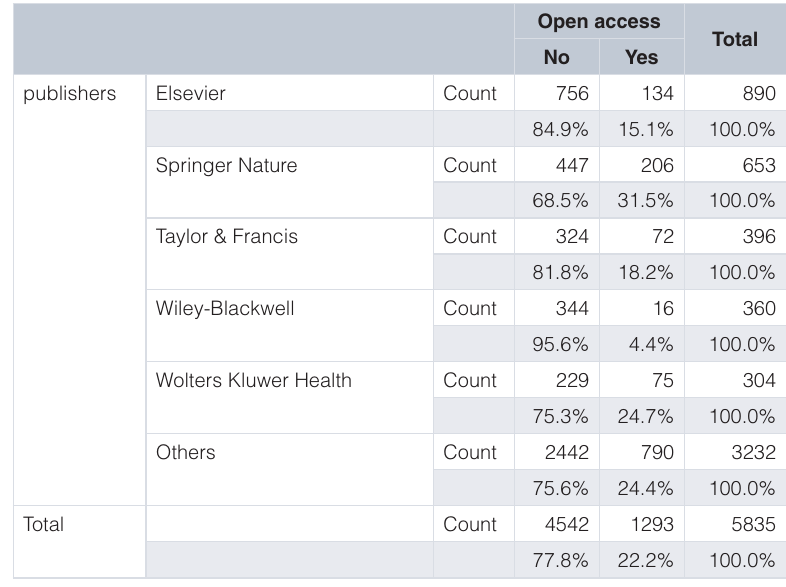
Table 2. A comparison in the percentage of open access (OA) journals between the top five publishers of medical journals.